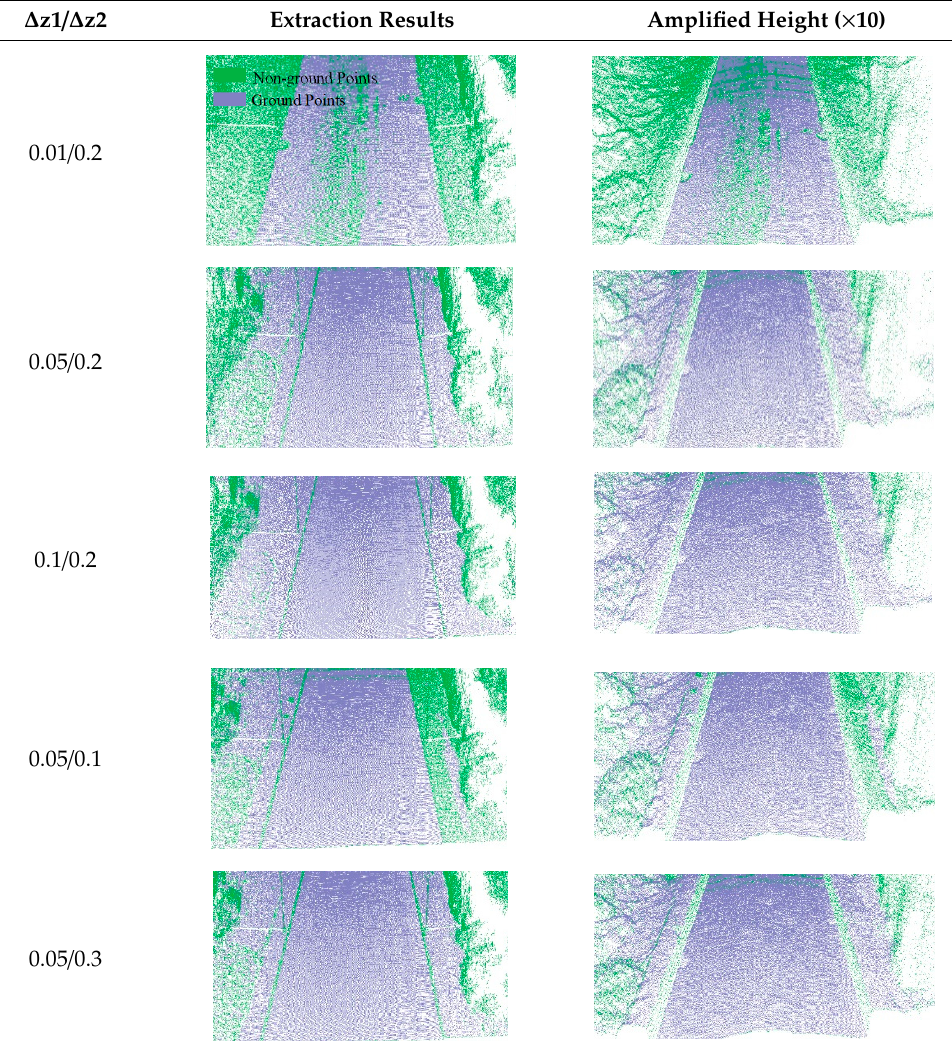
Table 3. Relationship between the extraction result and thresholds for curb points.